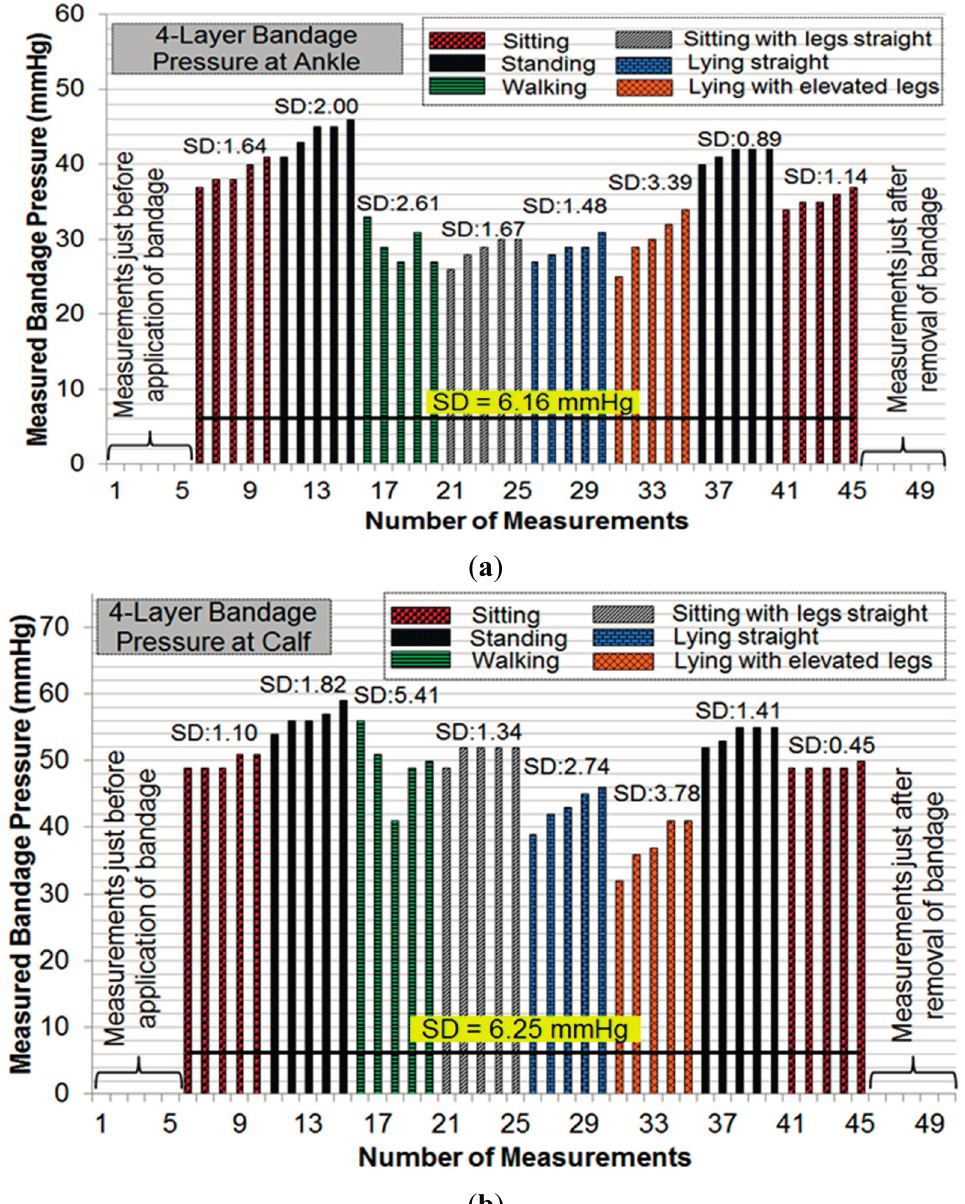
Figure 11. ( a ) Pressure measurements at the ankle with 4-layer bandage; ( b ) pressure measurements at the calf with 4-layer